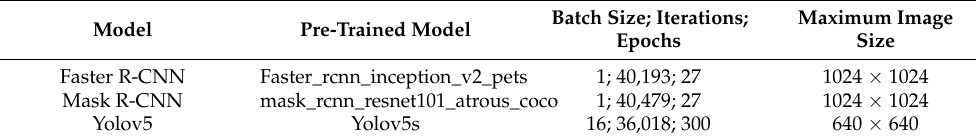
Table 1. Training Settings for different